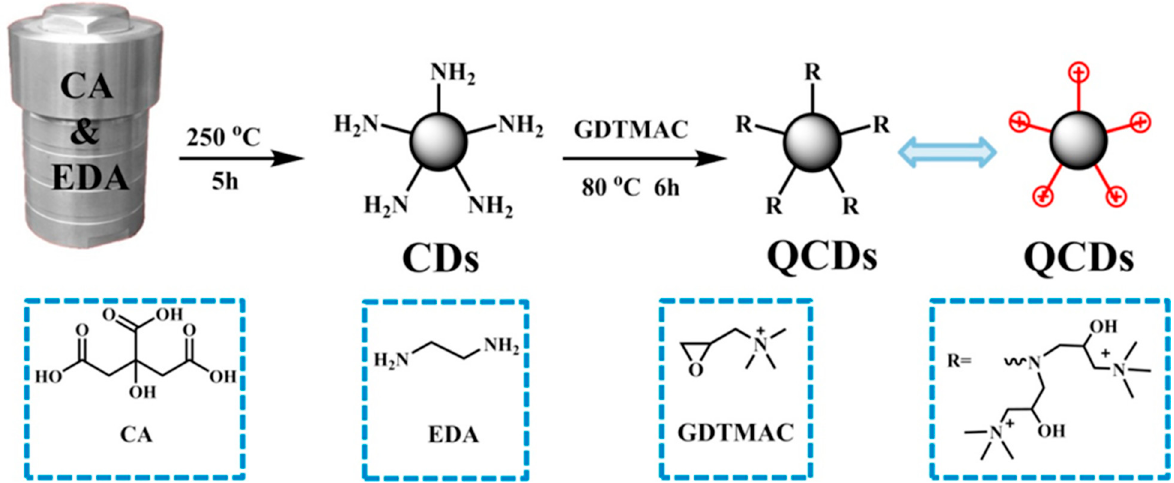
Figure 15. Synthesis of CDs and QCDs. Reproduced with permission from Ref. [139]. Table 5. Type of polymer and 3D filler in composite AEM with metal oxides and other inorganics. Polymer 3D